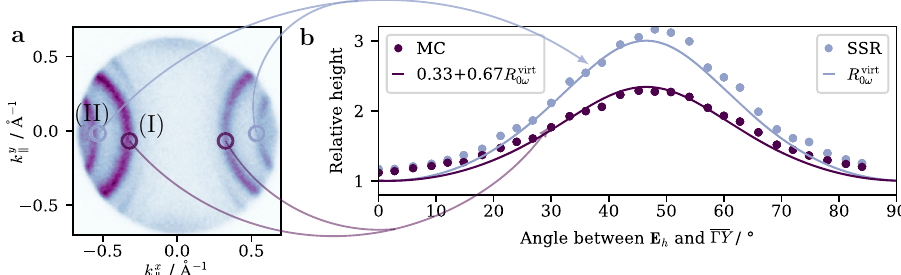
Fig. 5 Momentum resolved relative height of the cross-polarized correlation trace on Ag(110). a Constant energy map at E fi nal = 6.2 eV showing the Mahan cone transition (I) and the surface scattering resonance (II) 30 , representing transitions via virtual intermediate states. b The relative height dependent on the angle φ between E h and the Γ Y -direction for both features (dots), extracted and averaged from the circular regions of interest depicted in ( a ). The blue line shows the simulated relative height R virt (Eq. (8)). The purple line represents the relative height for a sp 2 -hybridized orbital, calculated by 0 ω assigning an orbital nature to the different cases of our